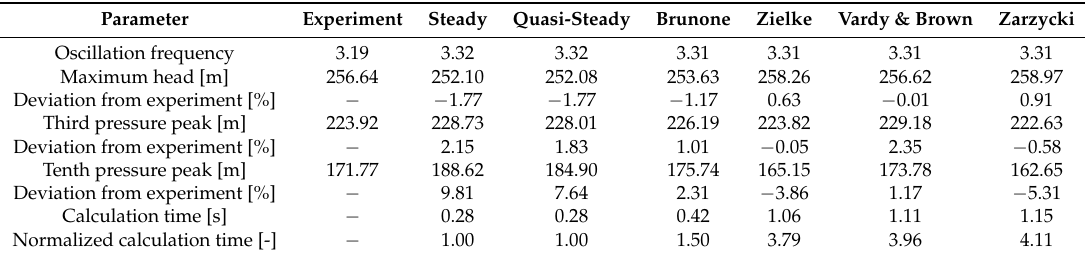
Table 3. Comparison of model and experimental results for experiment 2